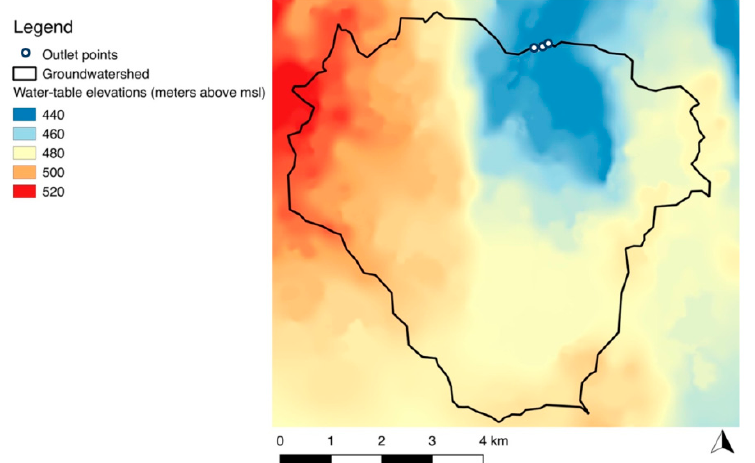
Figure 6. Map showing the interpolated water-table surface, outline of the Nicolet Creek/Elk Lake groundwatershed, and outlet points for watershed delineation.